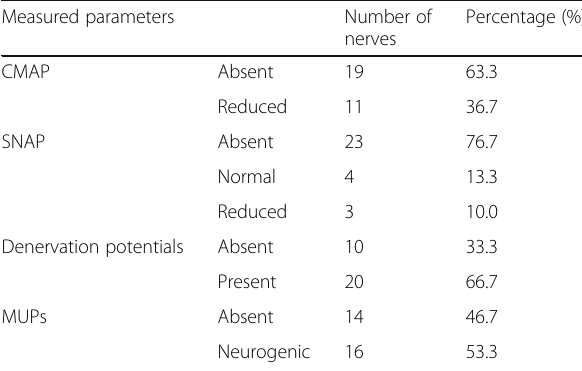
Table 2 Results of nerve conduction studies and electromyography Measured parameters